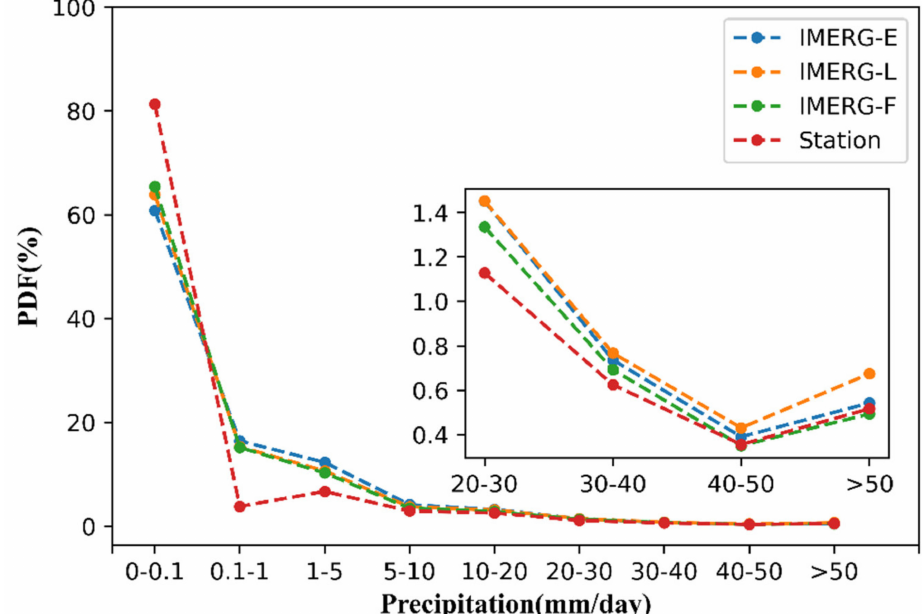
Figure 7. Probability density functions of precipitation intensity derived from land station measure- ments and IMERG